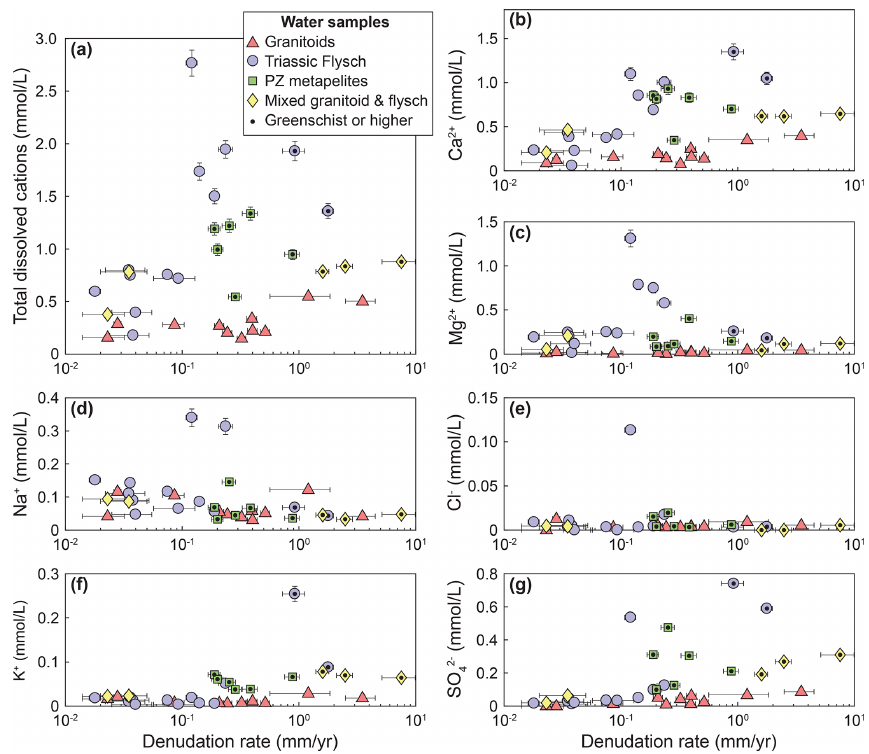
Figure 4. Solute concentrations vs. denudation rate. (a) Total dissolved cations. Spearman’s rank correlation coefficient and associ- = 0 . 43, p TDC = 0 . 19; ρ TDC = 0 . 63, p TDC = 0 . 03. (b) Ca 2 + concentrations ρ Ca 2 + ated p value: ρ TDC granite granite flysch flysch + = 0 . 73, p Ca 2 + = 0 . 006. (c) Mg 2 + concentrations. (d) Na + concentrations. (e) K + concentrations. (f) Cl − concentrations. (g) SO 2 − ρ Ca 2 flysch flysch